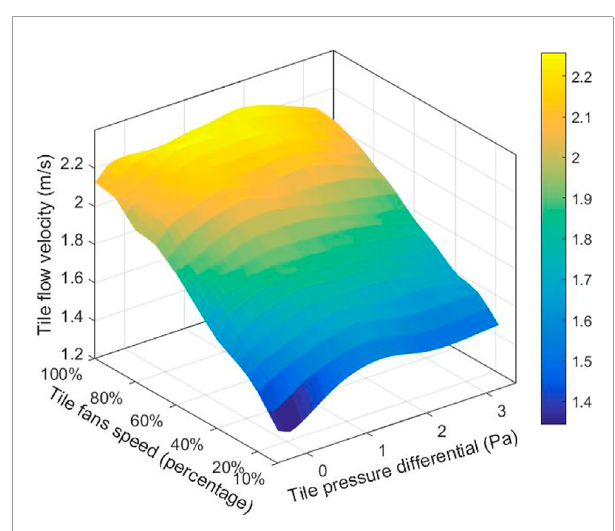
FIGURE 15 Relationship between pressure differential, fan speed and tile airflow